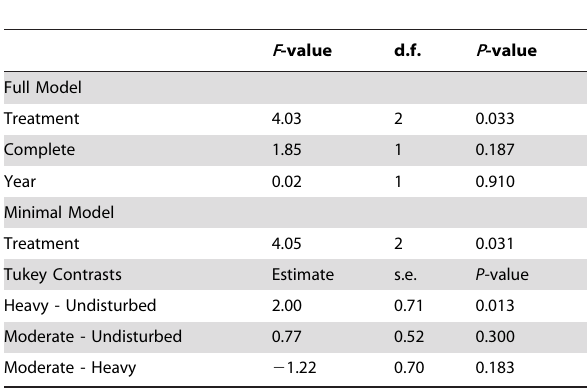
Table 2. Results of a linear mixed model for nestling male sex ratio, represented as the proportion of male nestlings within a given brood.